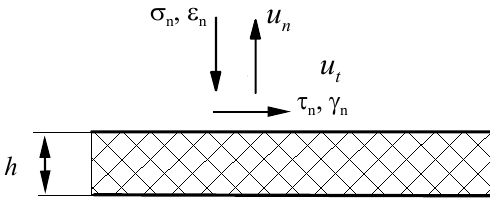
Figure 4: Dilation and stress in cyclic shear test: a) cyclic reversible dilatancy, b) cyclic dilatancy degradation, c) experimental data [22]